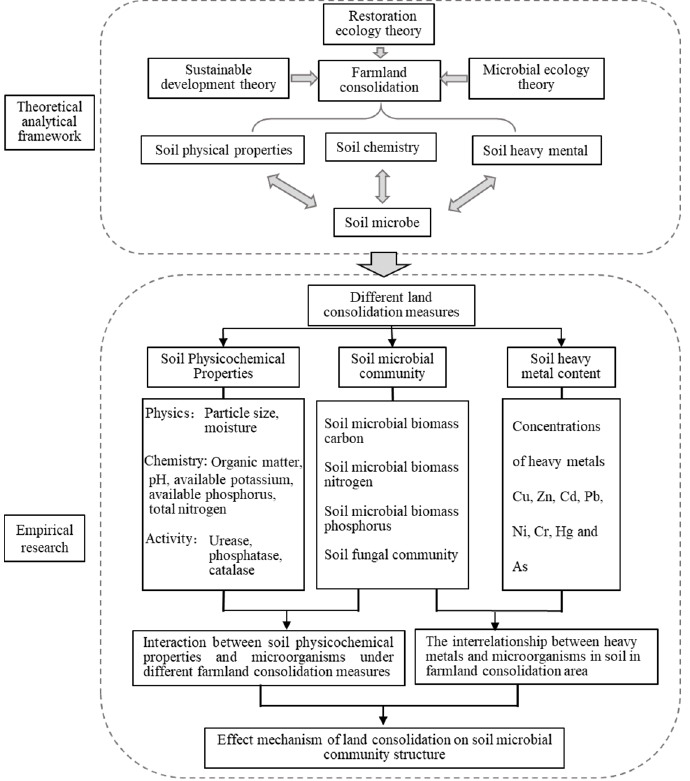
Figure 1. Research framework.